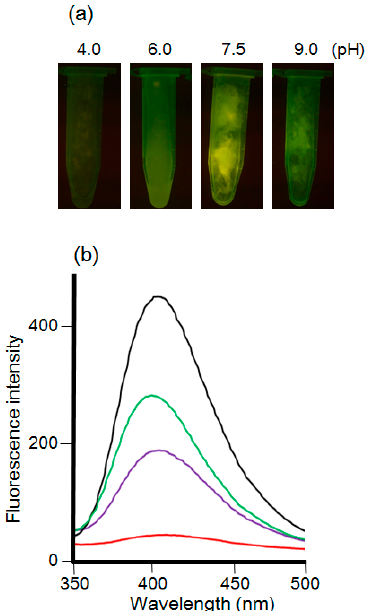
Figure 4. ( a ) F. oxysporum after the treatment of 5 mM CdCl 2 and 5 mM Na 2 SeO 3 in various conditions of pH observed under the UV light (wavelength: 365 nm). From the left side, each tube indicated pH 4.0, pH 6.0, pH 7.5 and pH 9.0 solutions, respectively; ( b ) The fluorescence spectra (excitation at 310 nm) of extracts from the mycelial cells in each condition using ultrasonication. Black line: pH 7.5. Green line: pH 9. Purple line: pH 6. Red line: pH 4.